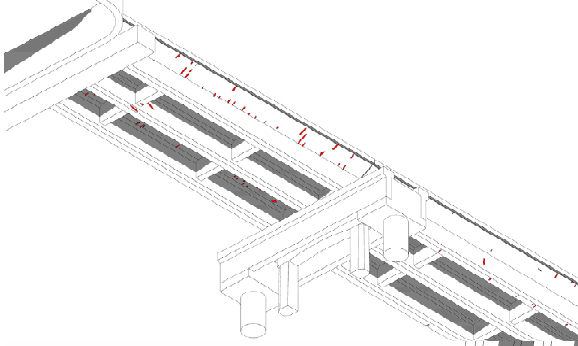
Figure 7. BIM model with the detected